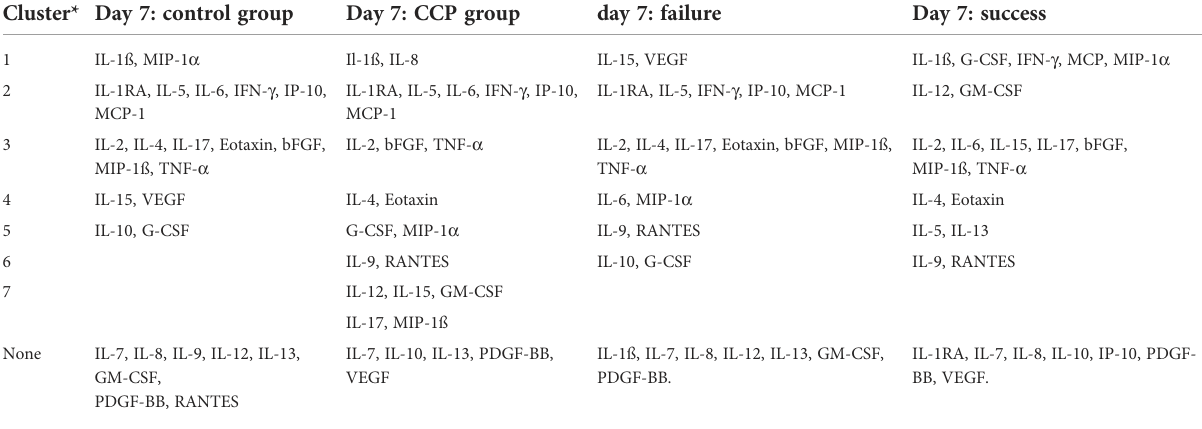
TABLE 2B Cluster report for the absolute values of the correlation matrix of all patients on day 7 strati fi ed by randomization group (control group versus CCP group) or by primary endpoint (failure versus success). Cluster* Day 7: control